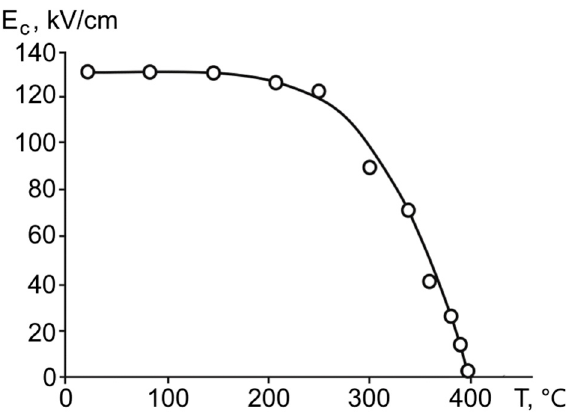
Figure 7. The temperature dependence of the coercive field for the ferroelectric BaZrO 3 /BaTiO 3 superlattice.